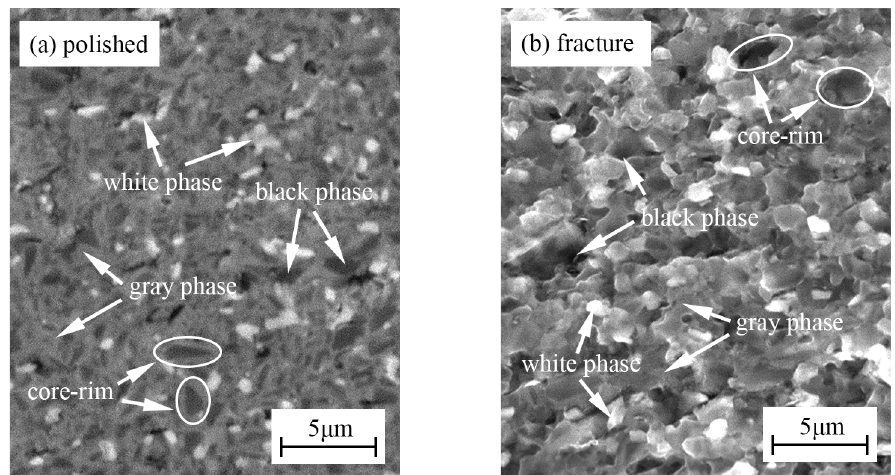
Figure 2. Polished surface and fracture morphology of TBHB before oxidation: ( a ) polished surface, ( b ) fracture morphology.